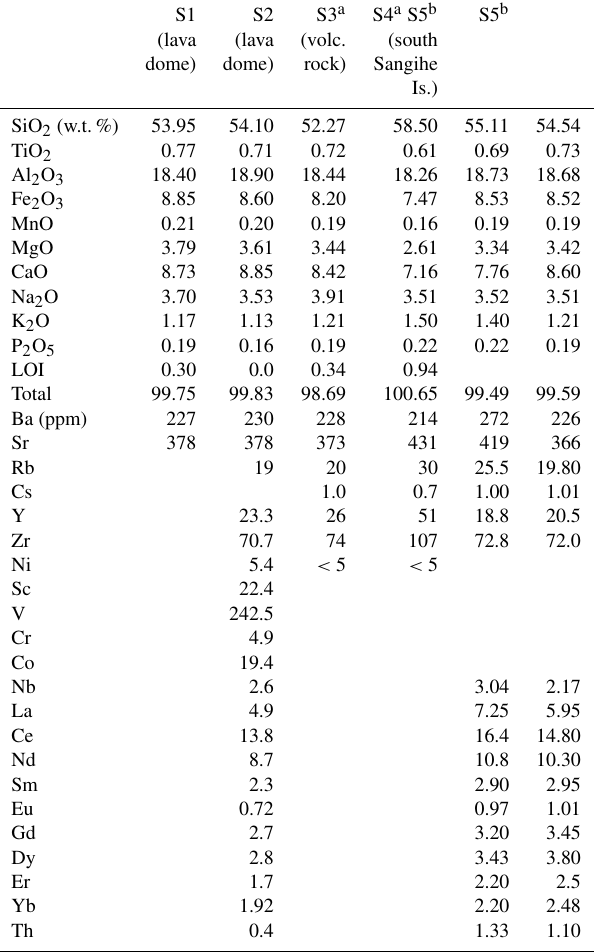
Surface (m 2 ) Corrected Surface occupied per temperature range (%) temp.